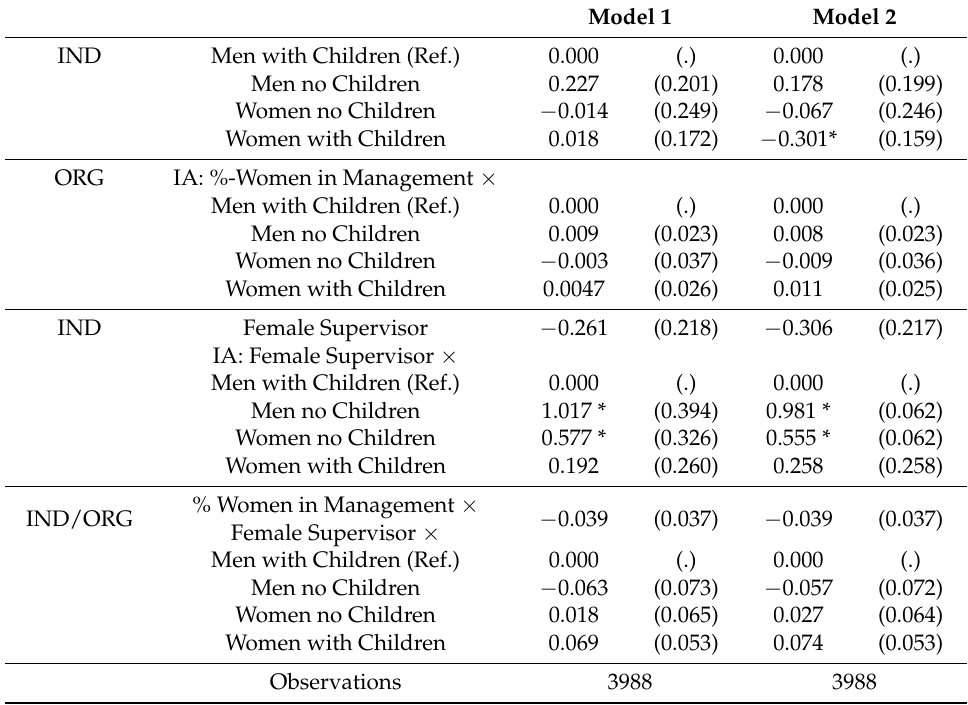
Table A2. Gender Gap in Claims-Making and Gendered Power Structure (results of logistic fixed-effects